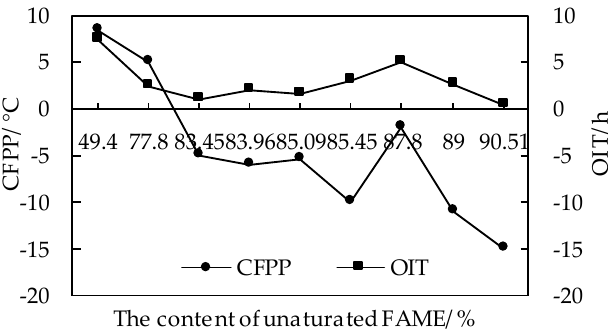
Figure 9. Effects of unsaturated FAME on low temperature fluidity and oxidation stability of biodiesel.